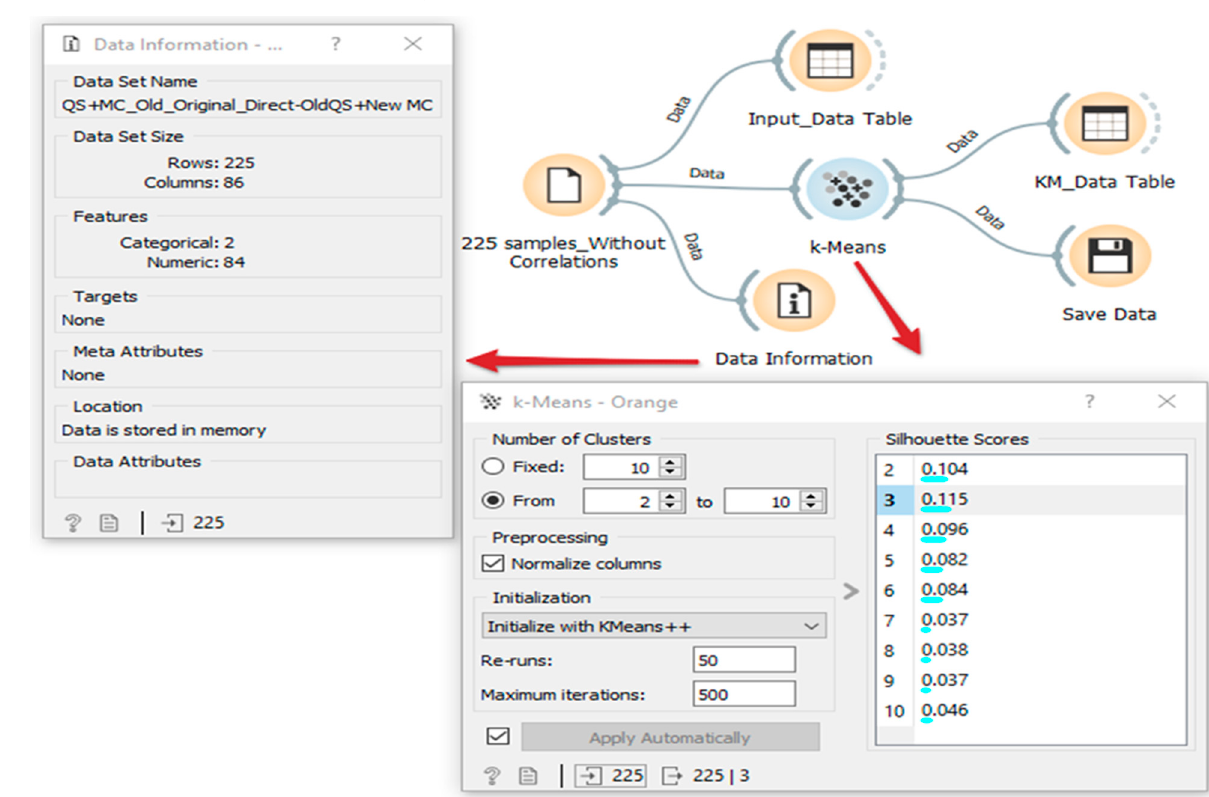
Figure 6. Workflow of direct KM algorithm.